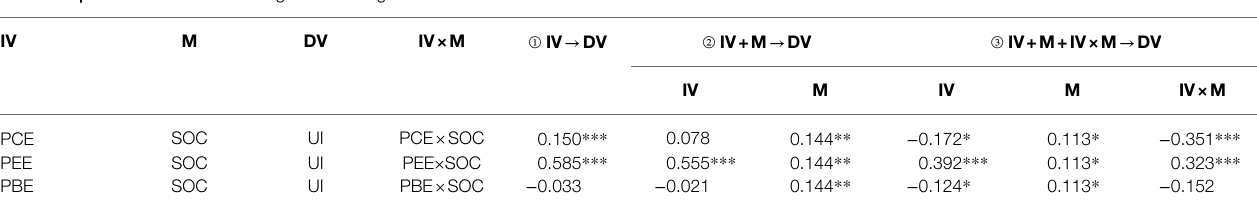
TABLE 7 | Results of the moderating effect